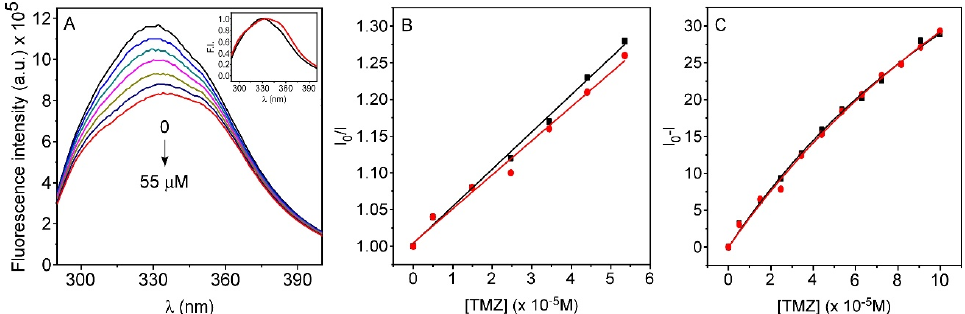
Figure 4. ( A ) Fluorescent emission spectra of human serum albumin (has) (6.2 µ M) ( λ exc = 280 nm) in water at 25 °C, and at increasing concentrations of TMZ. Inset: Normalized emission spectra of HSA in the absence (black) and the presence (red) of TMZ (55 μ M). ( B ) Stern–Volmer plots for quenching of HSA by TMZ in water (black) and sodium phosphate buffer pH 7.4 (red). ( C ) Plot of ∆ I = (I 0 ‐ I) versus [TMZ] in water (black) and sodium phosphate buffer pH 7.4 (red). Stern–Volmer plots, which show the relation between relative fluorescence intensities I 0 / I of the protein (calculated as the area under the spectra) and the molar TMZ concentration, are shown in